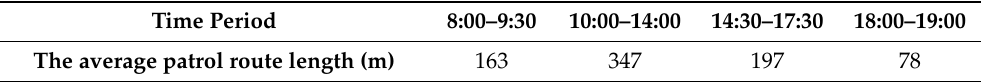
Table 5. The average patrol distance of evacuation guiders at different time periods.